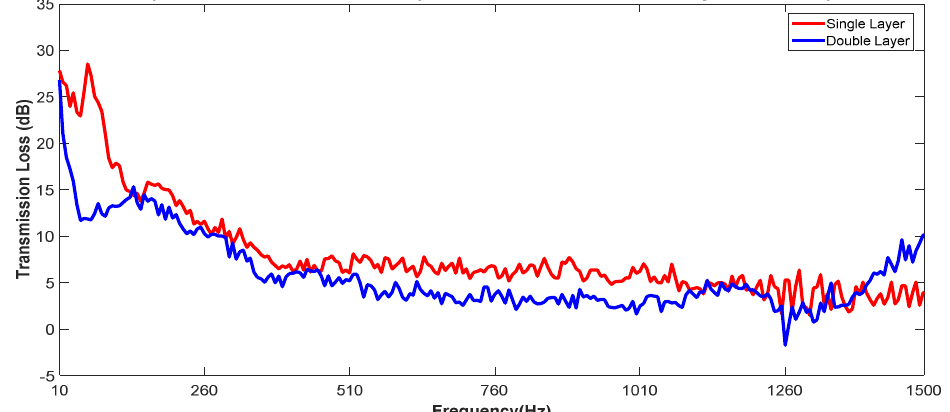
Fig. 6. The acoustic transmission loss versus frequency. The data were collected with air cross-velocity equal to (15m/s) using the perforated liners.